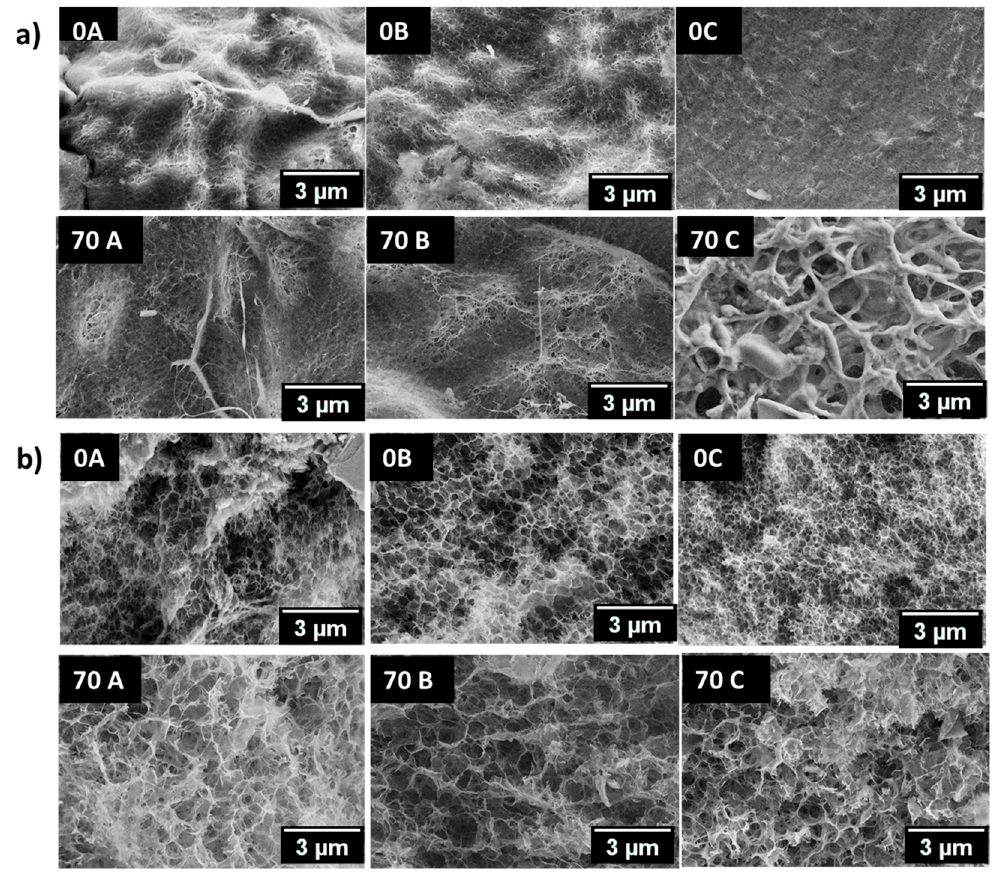
Figure 5. ( a ) Surface and ( b ) core morphology of 0A , 0B , 0C , 70A , 70B , and 70C chitosan–cellulose hydrogel beads with the scale bar 3 µm.